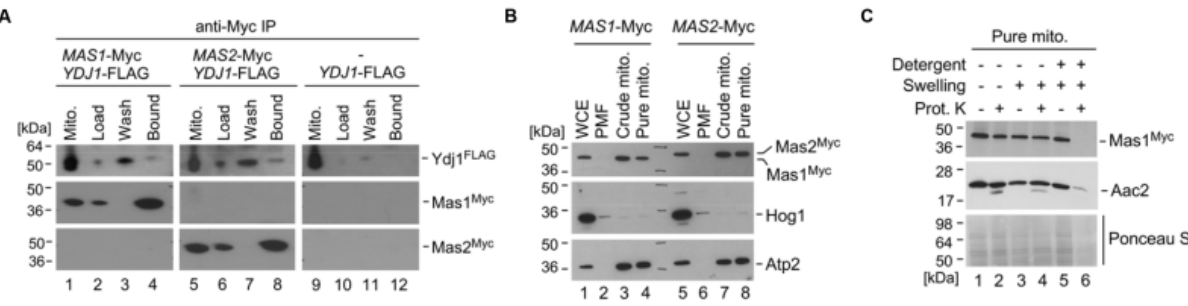
FIGURE 5: Ydj1 interacts with Mas1 and Mas2, which are localised to the mitochondria. (A) Gradient purified mitochondria from 2×FLAG- YDJ1/ydj1 , 2×FLAG- YDJ1/ydj1 MAS1 -Myc and 2×FLAG- YDJ1/ydj1 MAS2 -Myc incubated for 6 hours at 37 o C were lysed and used for the co- immunoprecipitation assay. A physical interaction between Ydj1 and Mas1 or Mas2 was determined by positive anti-FLAG and anti-Myc (Santa Cruz Biotechnology) antibody staining in the Bound fractions. (B) Whole-cell extracts (WCE), post-mitochondrial fractions (PMFs), crude and gradient-purified (pure) mitochondria were obtained from yeast cultures grown in YPD at 30 o C for 16 hours. Fractions were ana- lysed by SDS-PAGE and immunoblotting with antibodies against the Myc epitope (Roche) used to tag Mas1 and Mas2. The purity of the mitochondrial fractions was determined by the absence of a Hog1-specific band normally present in the cytosolic fractions. Antibodies against the inner mitochondrial protein Atp2 were used as a marker for the mitochondrial fraction. (C) Mas1 is localised to the mitochon- drial matrix. Gradient-purified mitochondria harboring Myc-tagged Mas1 were subjected to osmotic disruption of the outer mitochondrial membrane (Swelling) and lysis with dodecyl maltoside (Detergent) to disrupt the inner membrane in combination with Proteinase K (Prot. K) treatment. The fractions were subjected to Western blot analysis using anti-Myc antibodies to visualise Mas1 localisation, and anti- serum against the inner mitochondrial membrane protein Aac2 used as a marker for submitochondrial localization. Ponceau S staining was used to ascertain the loading of the mitochondrial